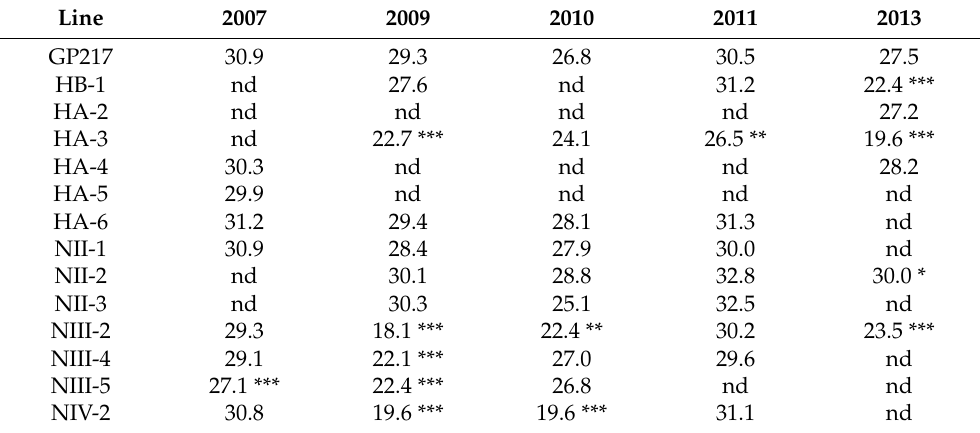
Table 2. Seed weight of pear progeny (mg).